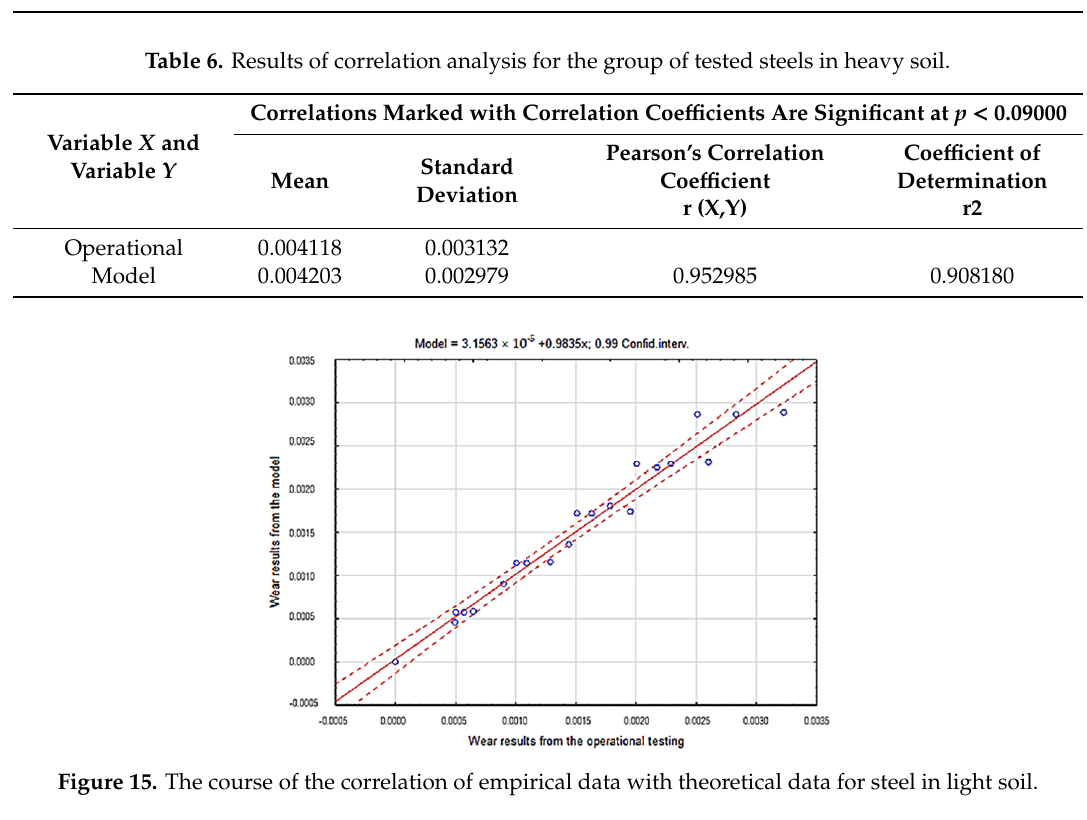
Table 4. Results of correlation analysis for the group of tested steels in light soil.